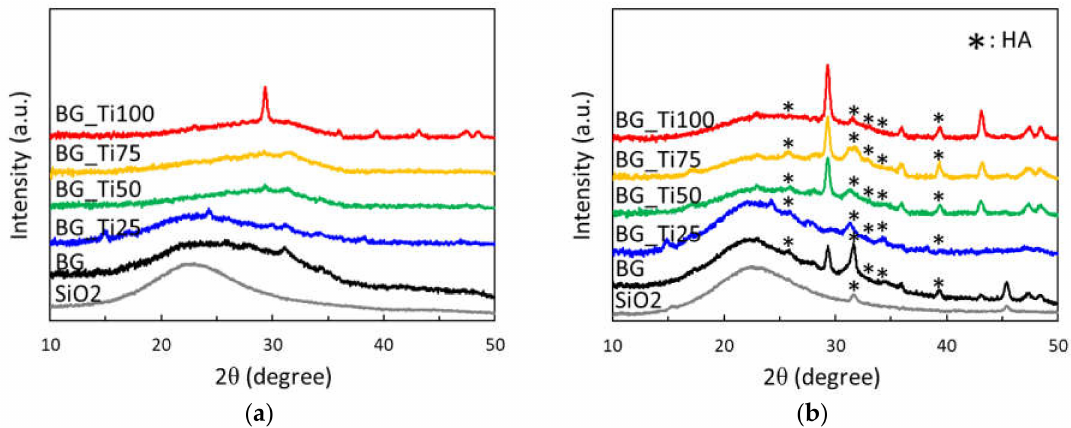
Figure 2. Phase identification by XRD of bioceramics composed of silica and titanium oxide with various concentrations of titanium oxide soaking in SBF for ( a ) 0 days and ( b ) 7 days.